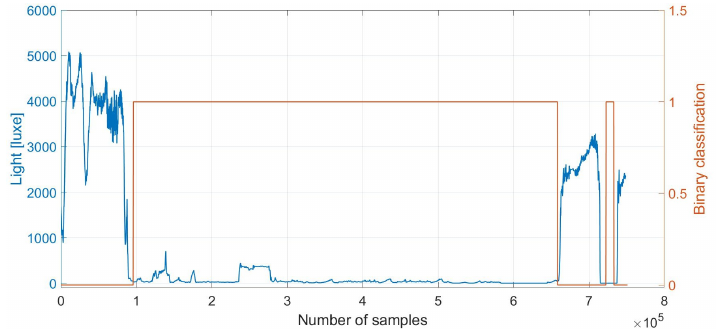
Figure 3. Outdoor–indoor transition (OITransition) classification using light. The binary flag of 1